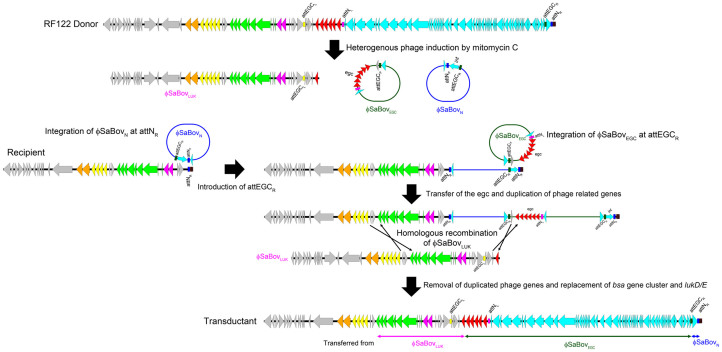
Proposed model for transfer of νSaβ mediated by φSaBov.Upon induction by mitomycin C, phage DNA (φSaBovN, φSaBovEGC, and φSaBovLUK) were excised from the RF122 chromosomal DNA and packed into phage head by terminase encoded in φSaBov. Upon entry to recipient strains, φSaBovN phage DNA is firstly integrated into recipient host chromosomal DNA through recombination between attNP (from φSaBovN) and attNR (recipient chromosomal DNA). This event introduces the attEGCR in recipient chromosomal DNA which allows φSaBovEGC phage DNA for integrating into recipient chromosomal DNA through recombination between attEGCP (from φSaBovEGC) and attEGCR (recipient chromosomal DNA). This event generates duplication of phage DNA. Homologous recombination occurs between φSaBovLUK phage DNA and integrated phage DNA, resulting removal of duplicated phage DNA. As a result of triple conversions, nearly all of the νSaβ from the donor strain is transferred to the recipient strain.